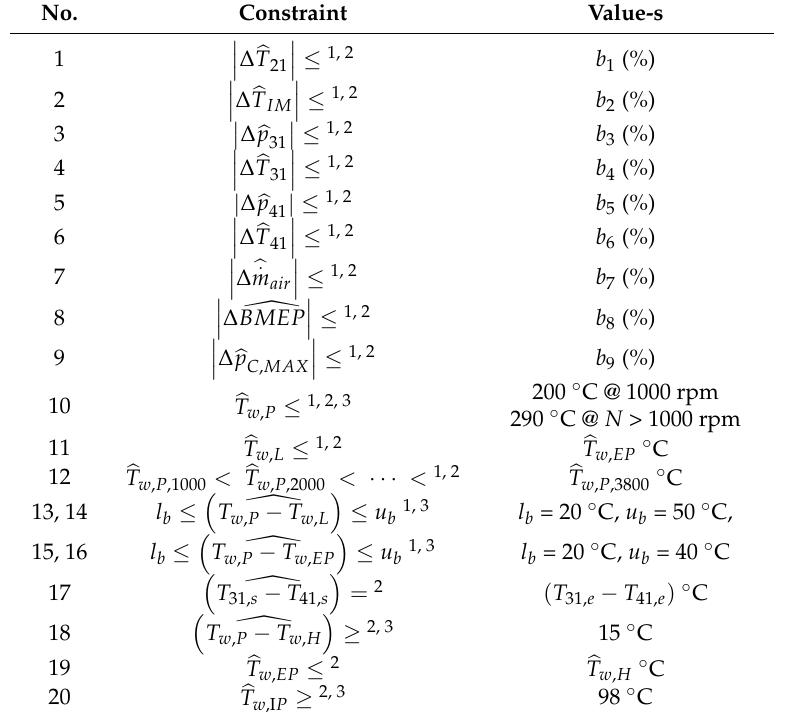
Table 3. Constraints used by the entire ICESM calibration applying RSM-based optimization. No. Constraint